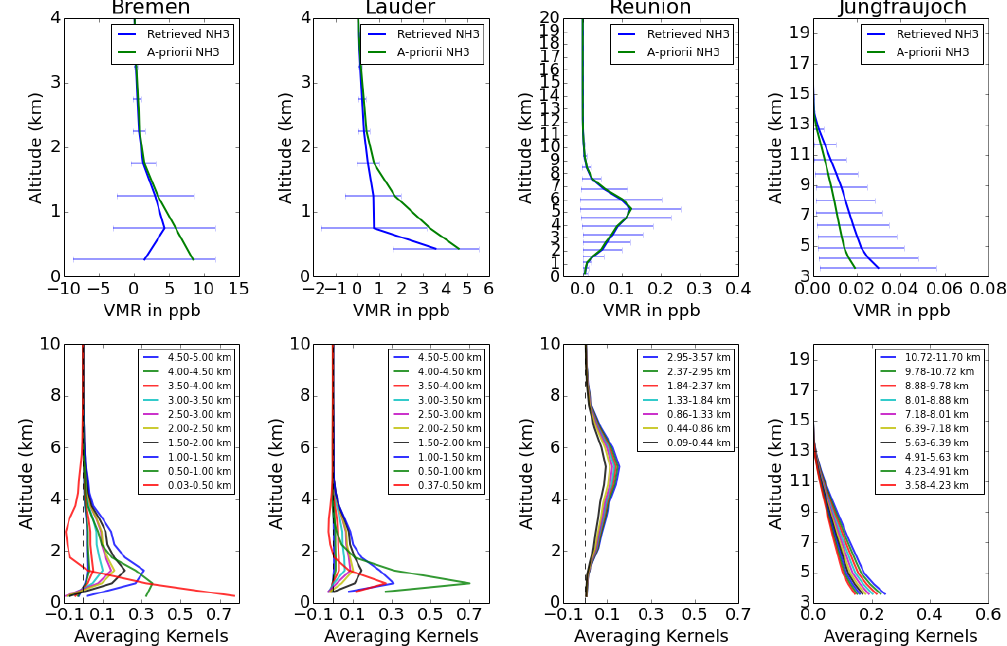
Figure 4. Top panels: the retrieved NH 3 profile (blue) and the a priori profile (green) in order from left to right: Bremen (left), Lauder (Left middle), Réunion Island (right middle) and Jungfraujoch (right). Horizontal lines indicate the standard deviation in all observations for each layer. Bottom panels: the normalized averaging kernel for each of the